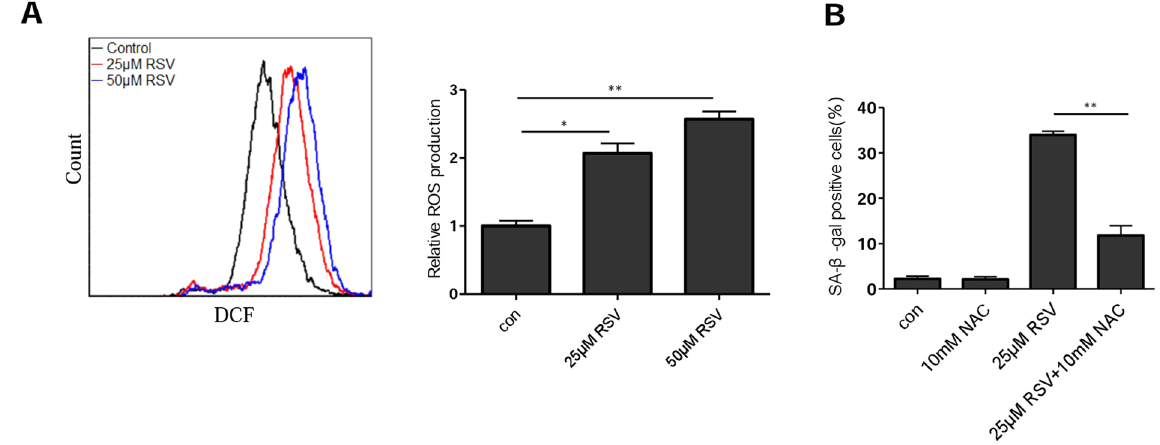
Figure 3. Resveratrol-induced cellular senescence can be attenuated by NAC. ( A ) U2OS cells were treated with different concentration of RSV for 48 h. ROS was measured by flow cytometry. Data summary was shown on the right, Mean of three independent experiments with SEM is shown. * P < 0.05, ** P < 0.01. ( B ) NAC